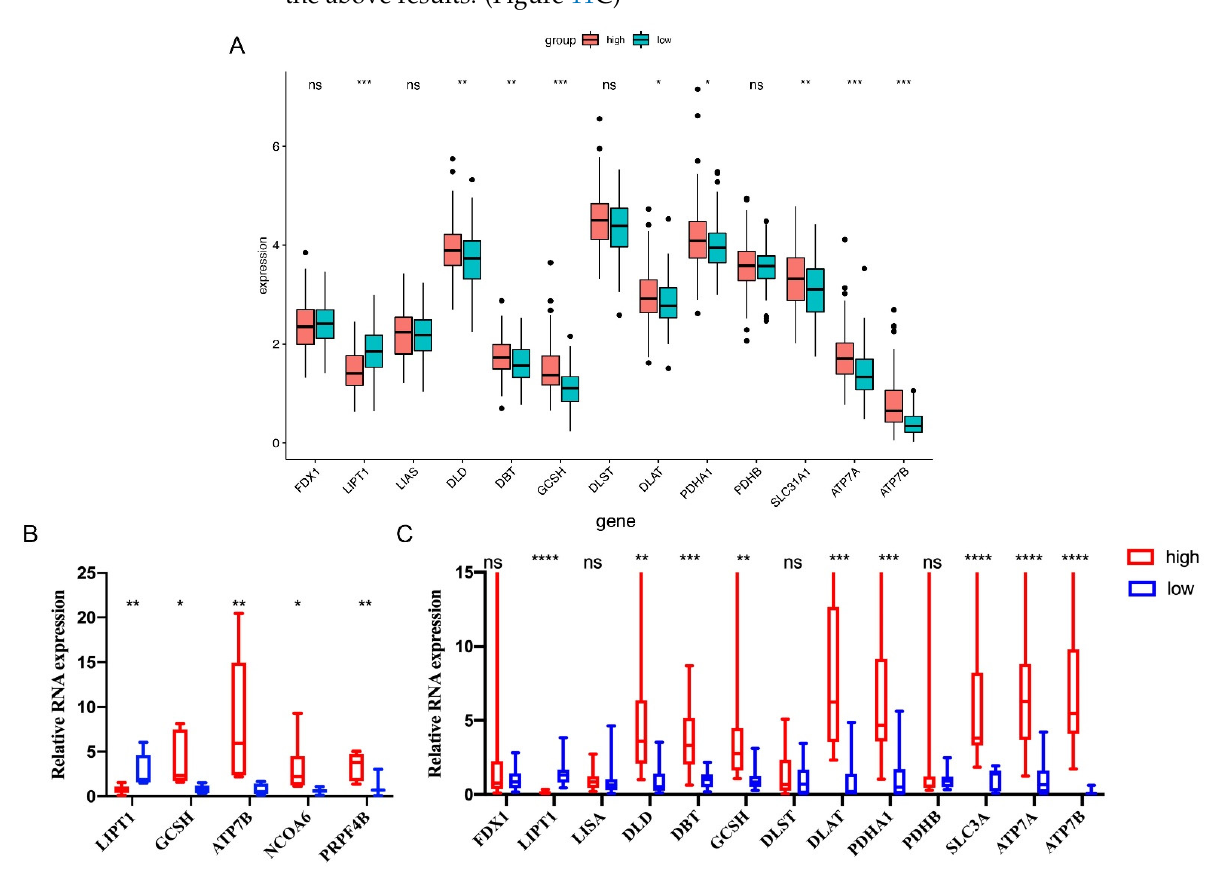
Figure 11. Relative expression level of selected CRGs in sarcoma tissues. The expression level of CRGs in high- and low-risk groups of patients with sarcoma by informatic analysis. ( A ) Validation of the expression of LIPT1, GSCH, ATP7B, NCOA6, and PRPF4B in sarcoma tissue between two groups ( B ) The expression level of LIPT1, DLD, DBT, DLAT, PDHA1, PDHB, SCL31A1, ATP7A, and ATP7B between the high- and low-risk groups ( C ). GAPDH was used as the internal reference gene for qRT-PCR relative expression. Error bars indicate the standard deviation or the standard error of the data. * p < 0.05. ** p < 0.01. *** p < 0.001. **** p < 0.0001. ns: not significant.